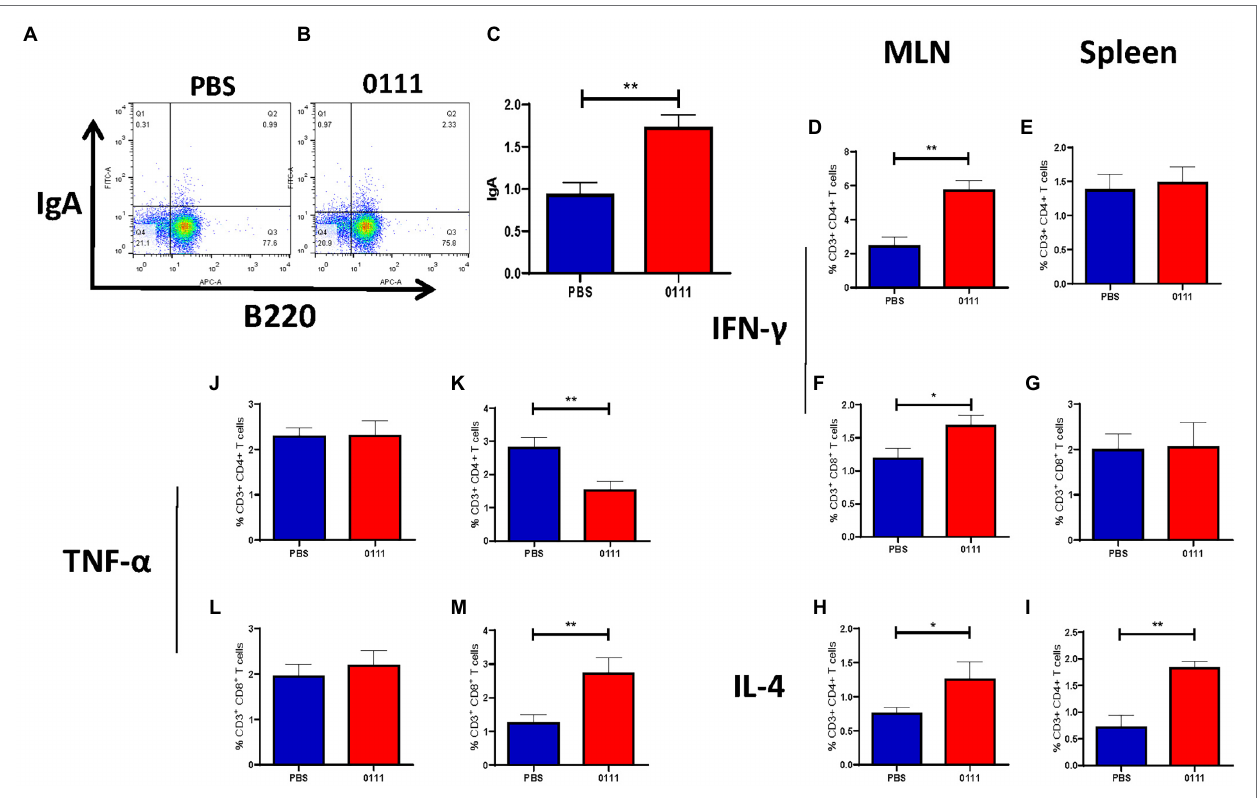
FIGURE 7 | 0111 regulates adaptive immunity. C57BL/6 mice ( n = 5/group) were euthanized by the continuous oral administration of L. plantarum 0111 (1 × 10 8 CFU/200 μ l/mouse), single cells were prepared as described, and flow cytometry analysis was performed using the indicated gating method (A) . CD4 + IFN- γ + T cells (D) , CD8 + IFN- γ + T cells (F) , CD 4 +1L-4 + T cells (H) , CD4 + TNF- α + T cells (J) , and CD8 + TNF- α + T cells (L) in MLNs and CD4 + IFN- γ + T cells (E) , CD8 + IFN- γ + T cells (G) , and CD4 + 1L-4 + T cells (I) in the spleen of immunized mice were calculated. The percentages of CD4 + TNF- α + T cells (K) and CD8 + TNF- α + T cells (M) . The number of B220 + IgA + B cells cells in the Peyer patches of the PBS group (A) and L. plantarum 0111 group (B) as well as statistical analysis (C) . The results were calculated for statistical significance using the t -test. * P < 0.05; ** P <